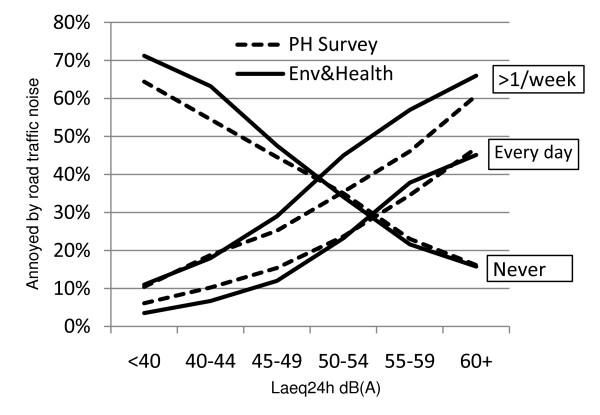
Proportion of respondents annoyed by road traffic noise more than once per week in relation to noise exposure. Also extreme alternatives in questionnaire presented. "Every day" (ascending line) and "Never" (descending line).